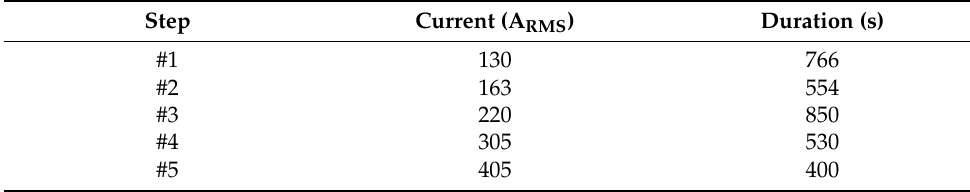
Table 4. Conductor of 150 mm 2 . Realized temperature rise tests.